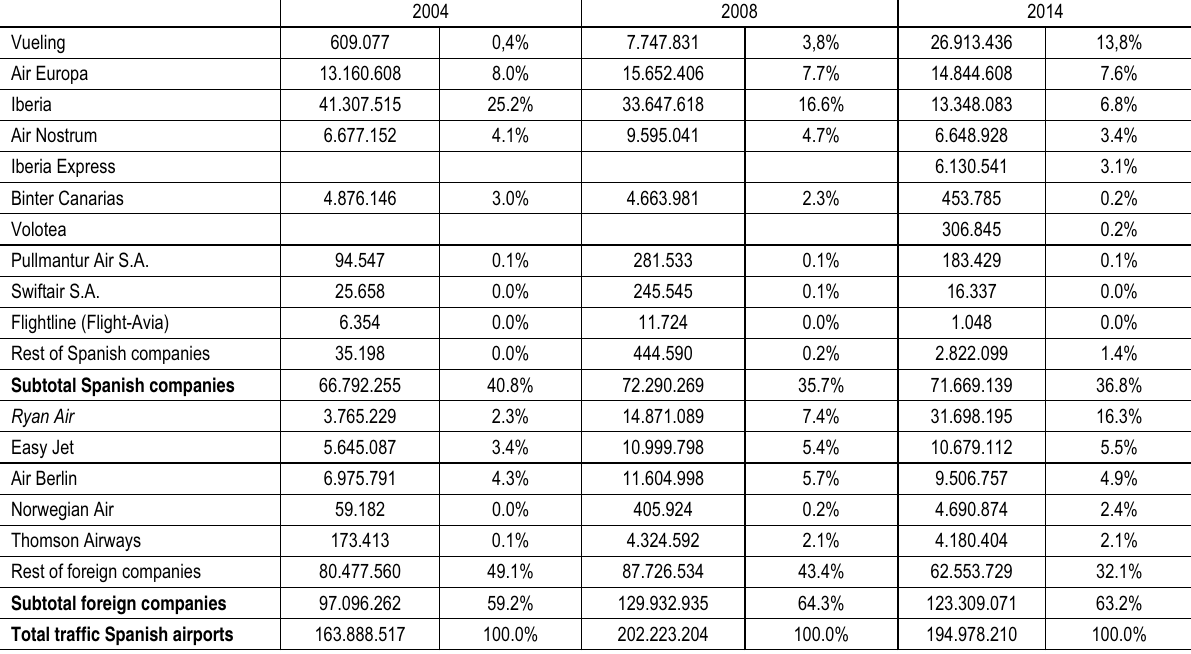
Table 1. Evolution of the number of passengers by each airline